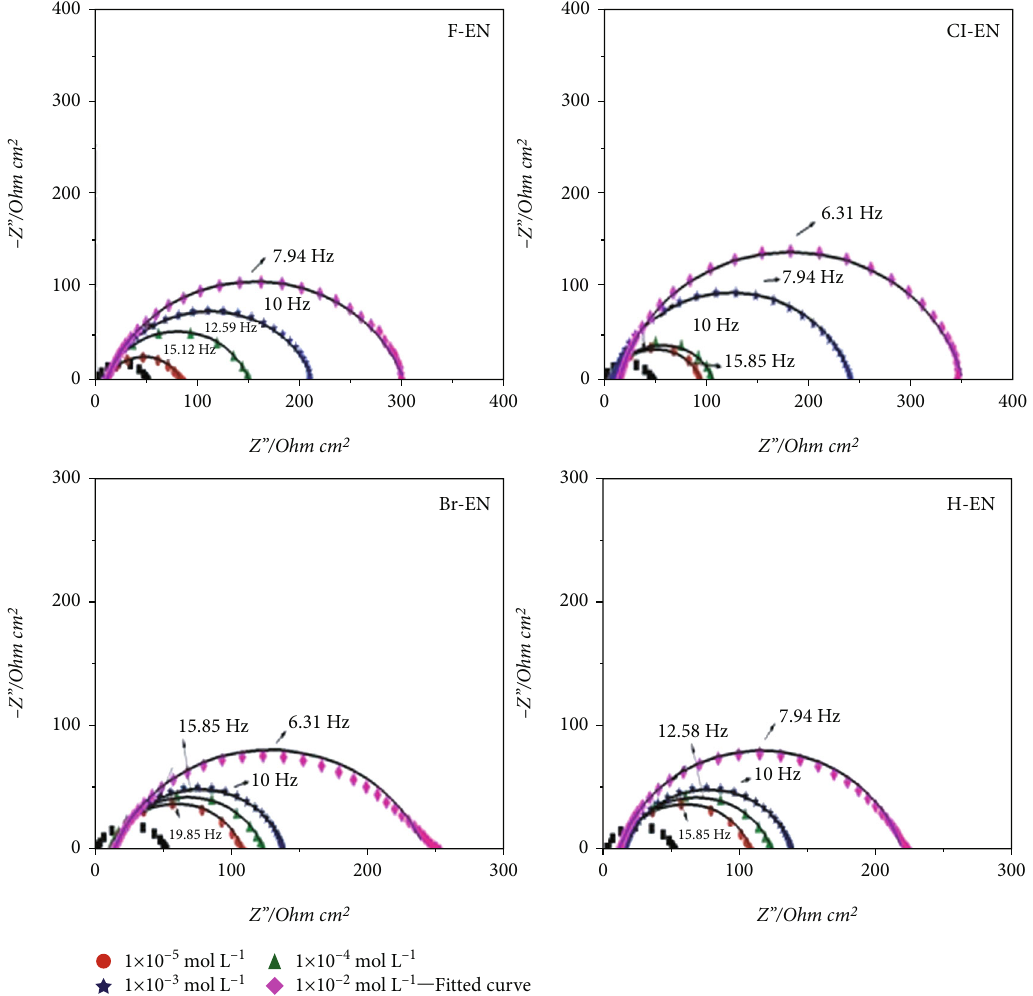
Figure 2: Nyquist plots obtained in absence and presence of inhibitors against AISI 1020 carbon steel in 1.0mol L -1